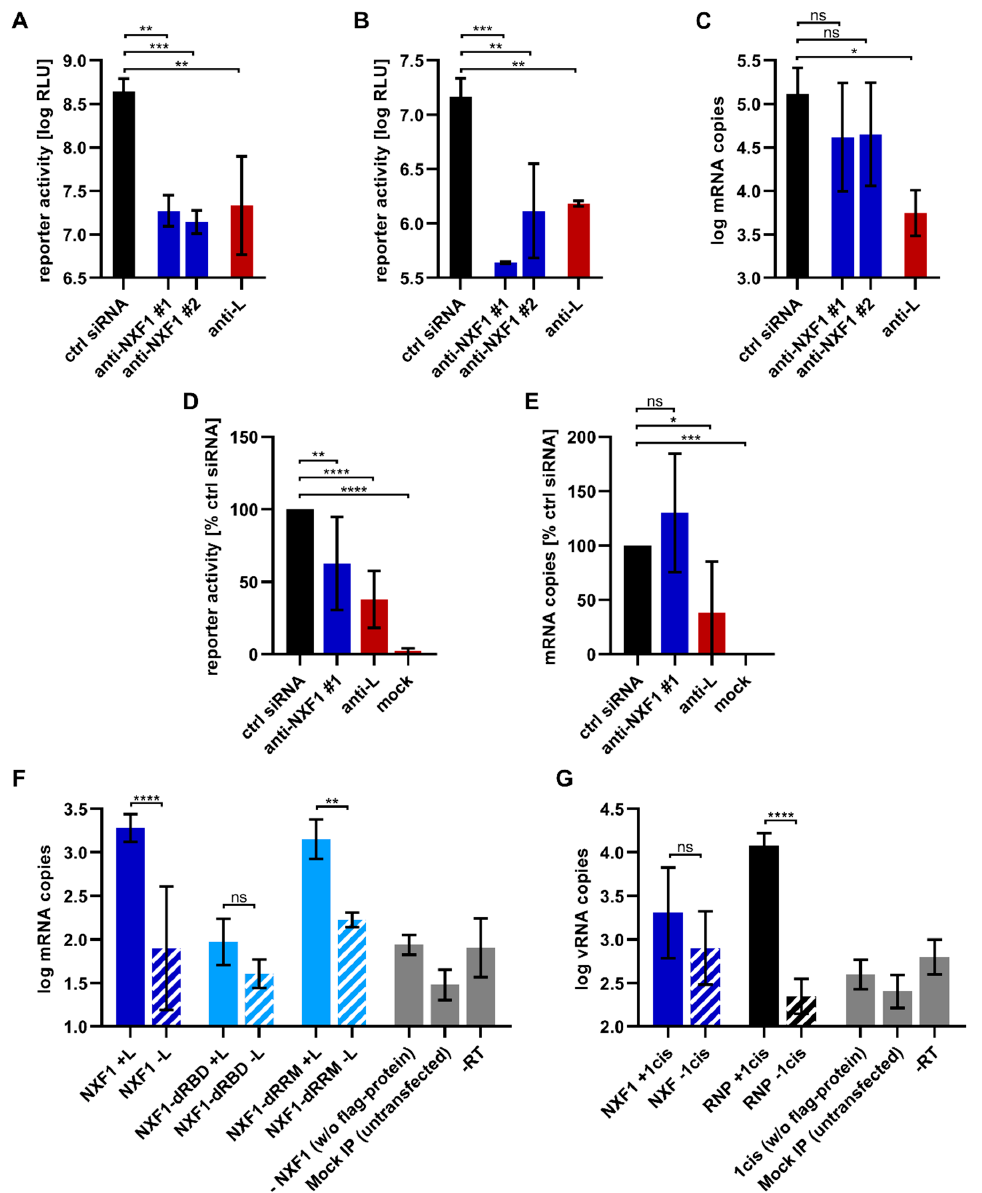
Figure 7. Influence of NXF1 on viral RNA synthesis and protein expression and interaction of NXF1 with viral RNAs. ( A ) Analysis of viral RNA synthesis and protein expression in NXF1 knockdown cells. 293T cells were transfected with siRNAs targeting either NXF1 (anti-NXF1) or L (anti-L) or with a negative control (ctrl) siRNA. Forty-eight hours p.t., cells were transfected with the